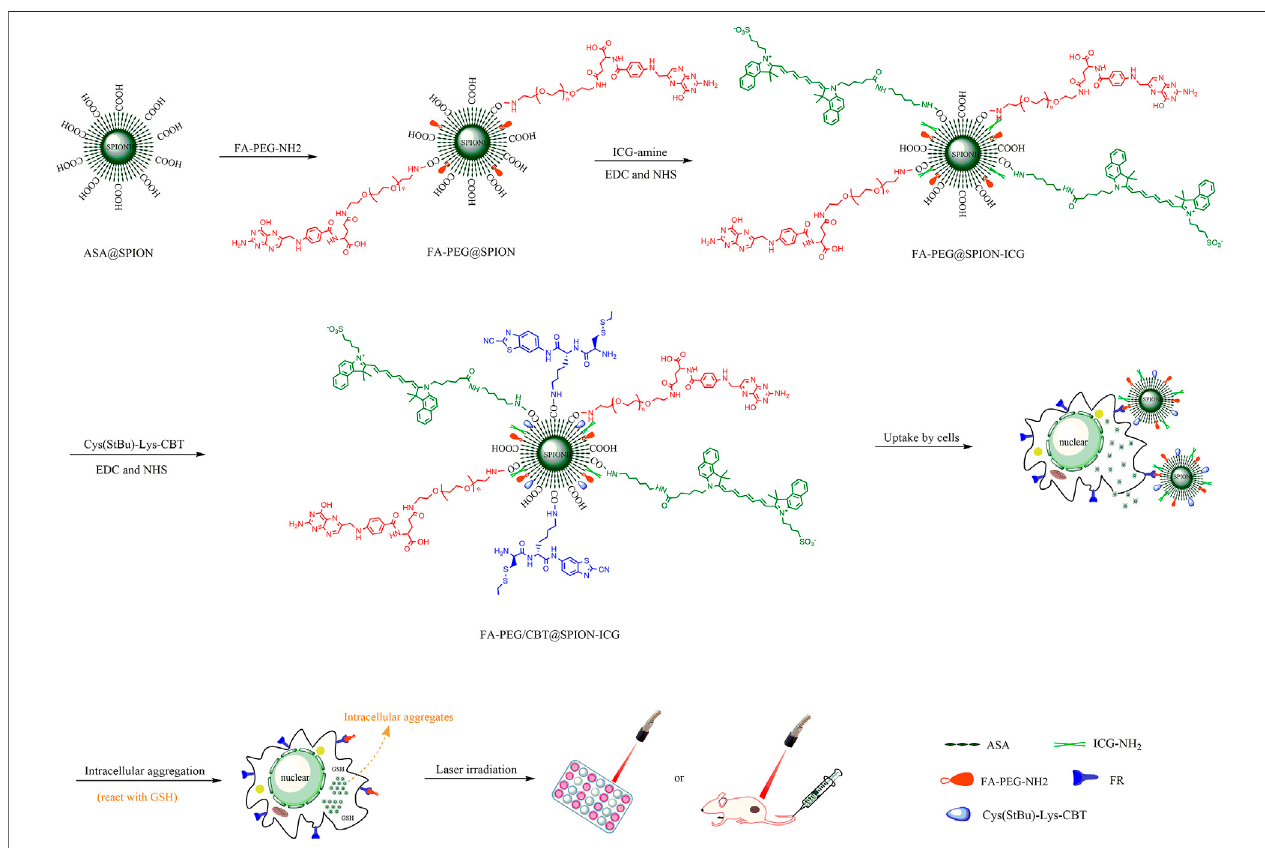
FIGURE 1 | Schematic illustration of the construction of FA-PEG/CBT@SPION-ICG and photothermal therapy of nasopharyngeal carcinoma.